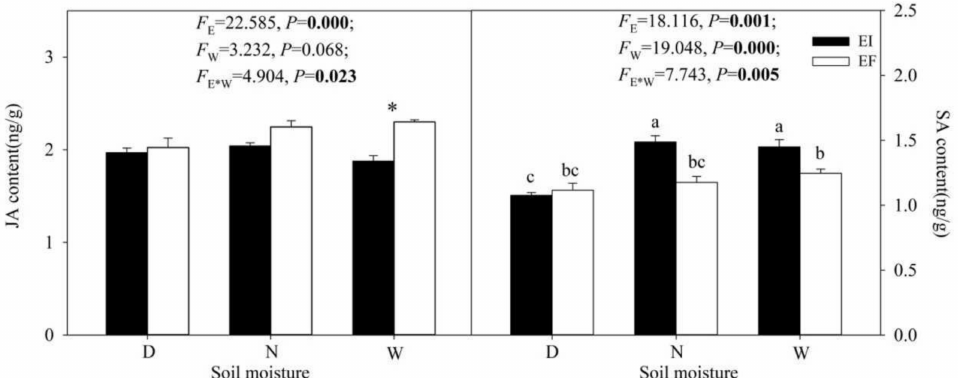
Figure 5. The JA and SA content under different moisture content and endophyte treatments (D: drought, N: normal, W: well-watered, EI: endophyte infected and EF: endophyte free). Values are means, with standard error bars (n = 3). The asterisk (*) means significant difference at p < 0.05 between EI and EF plants at corresponding water content. Columns with non-matching letters indicate a significant difference at p <